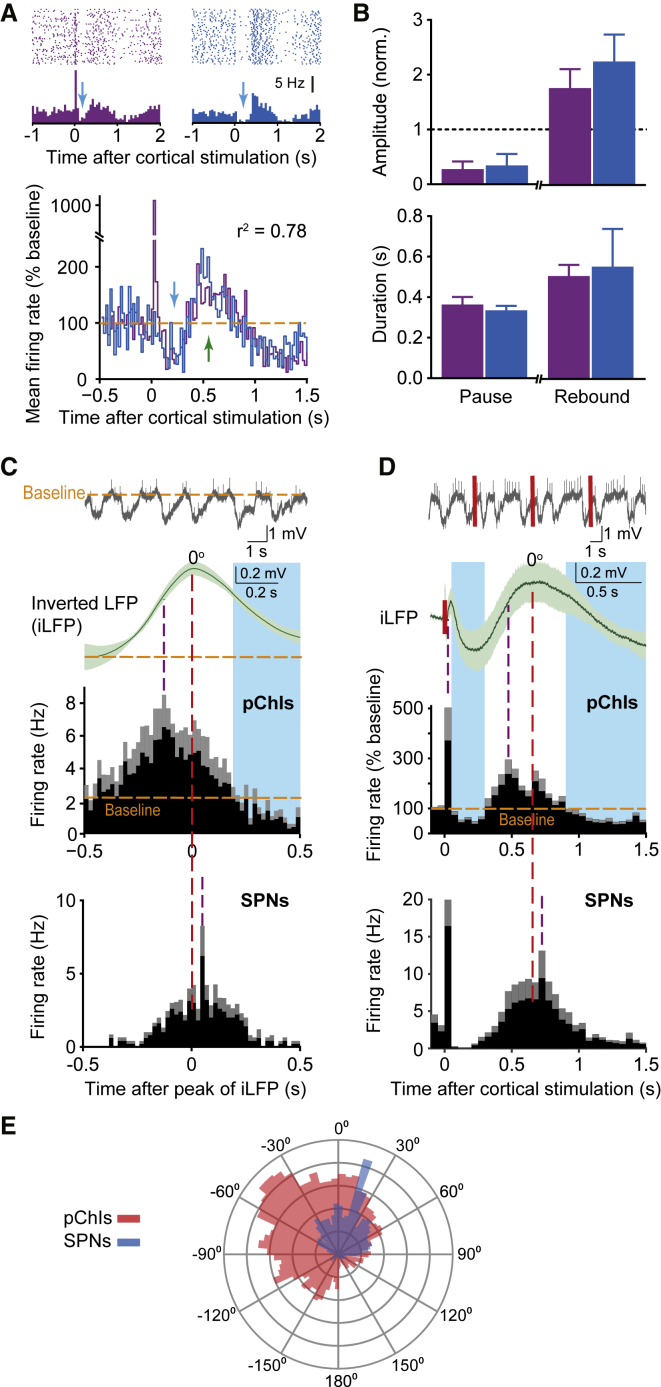
In Vivo Firing Rate of pChIs Reflects Changes in Excitatory Input, with Pauses Accompanying Withdrawal of Excitation(A) Firing of pChIs with (left, purple) or without (right, blue) short-latency-evoked action potentials before a pause. Top: example; bottom: average, pause (blue arrow), rebound (green arrow). Firing rate correlation, r2 = 0.78, p < 0.001 (n = 4–5).(B) Mean ± SEM for amplitude (top) and duration (bottom) of pause and rebound.(C and D) Top: example striatal LFP; middle top: mean ± SEM of inverted LFP (iLFP); middle: mean firing rate (black) ± SEM (gray) in pChIs (n = 5, n = 9); bottom: mean firing rate (black) ± SEM (gray) in SPNs (n = 5) aligned to maximum of spontaneous iLFP (dashed red line) (C) or contralateral cortical stimulation (0.2 Hz; solid red lines) (D). Purple dashed line, firing rate maxima; shaded blue, pChI firing rate below baseline, a “pause.”(E) Phase plot of firing rates for ChIs and SPNs. Data were extracted during slow LFP oscillation in (D).